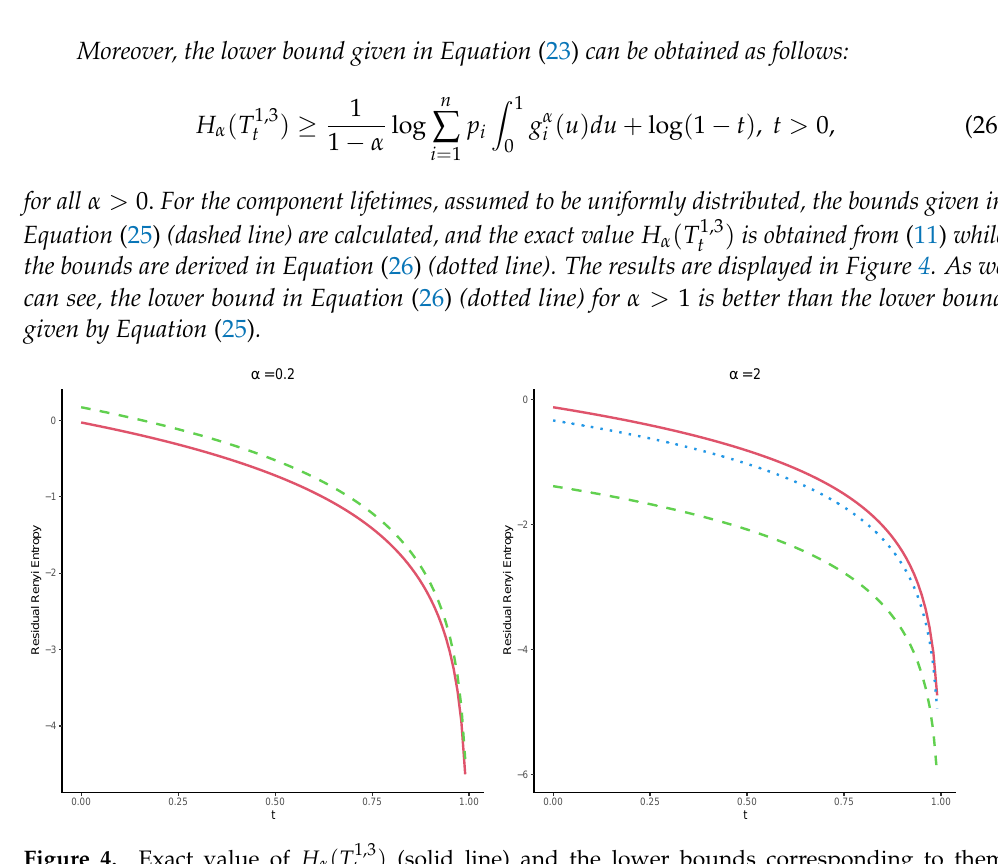
) (solid line) and the lower bounds corresponding to them Figure 4. Exact value of H α ( T 1,3 t (Equation (21) (dashed line) and (25) (dotted line)) for the standard uniform distribution concerning time t